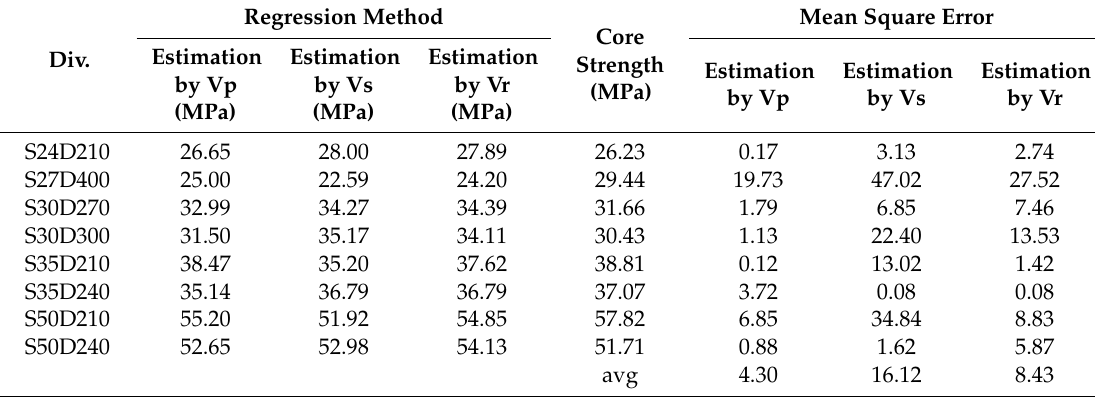
Table 9. Mean squared error of regressions for P-, S-, and R-wave velocities.